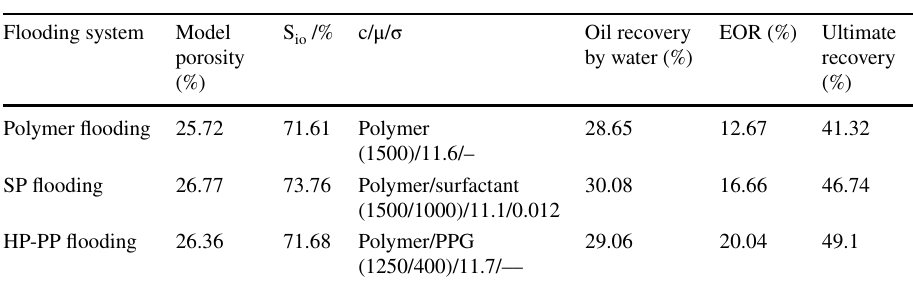
Table 3 Properties of the different flooding systems and displacement experiment results